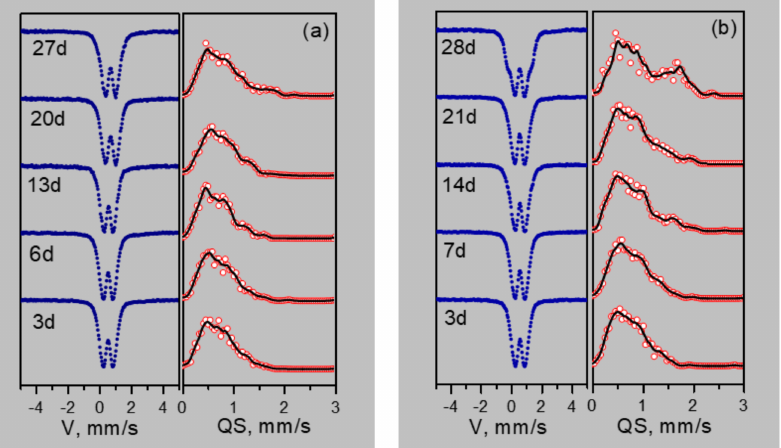
Figure 4. Mössbauer spectra and distributions of quadrupole splitting of nanoparticles depending on the duration of cultivation on media containing various forms of iron (Fe 2+ oxalate ( a ) and Fe 3+ citrate ( b